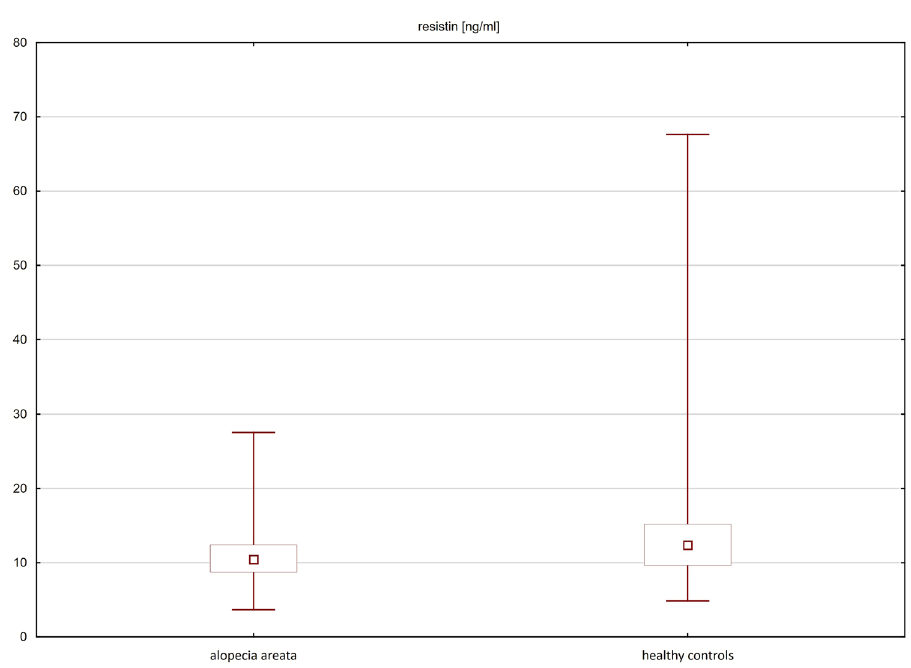
Figure 2. Serum concentrations of resistin in patients with alopecia areata and healthy